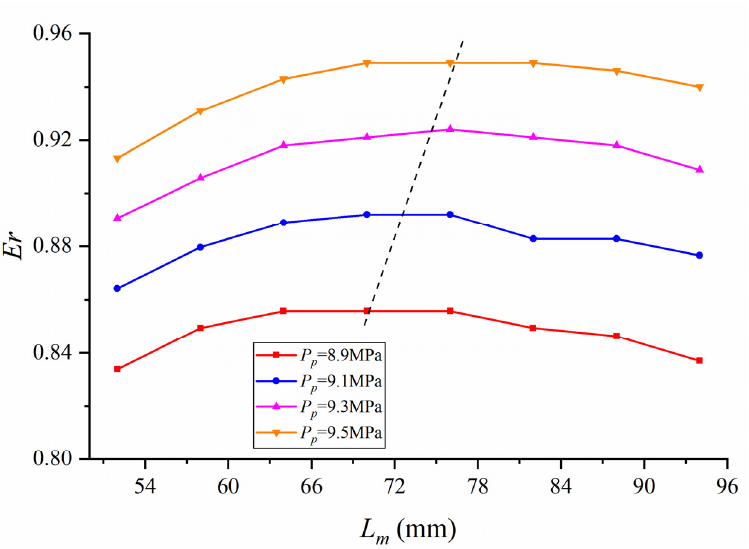
Figure 10. Variations of Er with different L m and P p ( D m of 8 mm, θ pm of 60.4°). In terms of P p at 9.3 MPa, the least Er of 0.891 is recorded for 52 mm, while the greatest Er of 0.924 is recorded for 76 mm. The percentages of increase in Er by varying L m from 52 mm to 94 mm for four sets of P p are 2.6%, 3.2%, 3.7% and 3.9%, respectively. The broken line in the figure shows the relationship between optimal L m and P p , to be specific, that the optimal L m of each curve representing Er increases with the rise of P p . The broken line also indicates that the optimal L m is not overly sensitive to the change of P p , and the optimal L m is recorded from 64 mm to 82